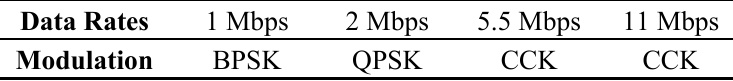
Table 2. IEEE 802.11b/g